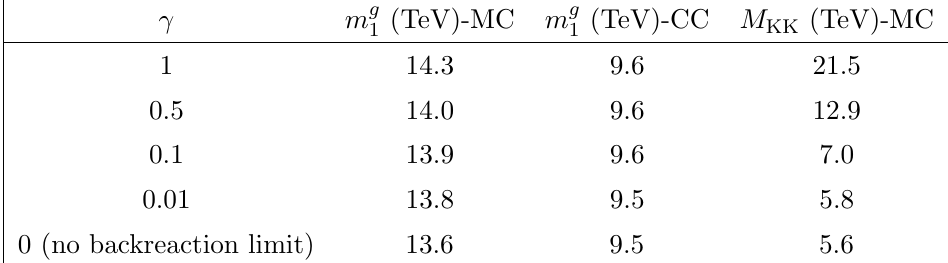
Table 1 . Mass of the lightest KK gluon satisfying the constraints from EWPT at 95% CL for the minimal case (MC) and the custodial case (CC). The parameter (cid:13) , which is varied between 1 and 0, determines the strength of the backreaction. We (cid:12)xed shows M KK as de(cid:12)ned in (2.52) for the minimal